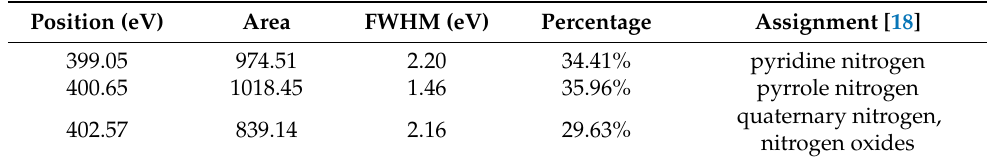
Table 5. Peak-fitting results of N 1s